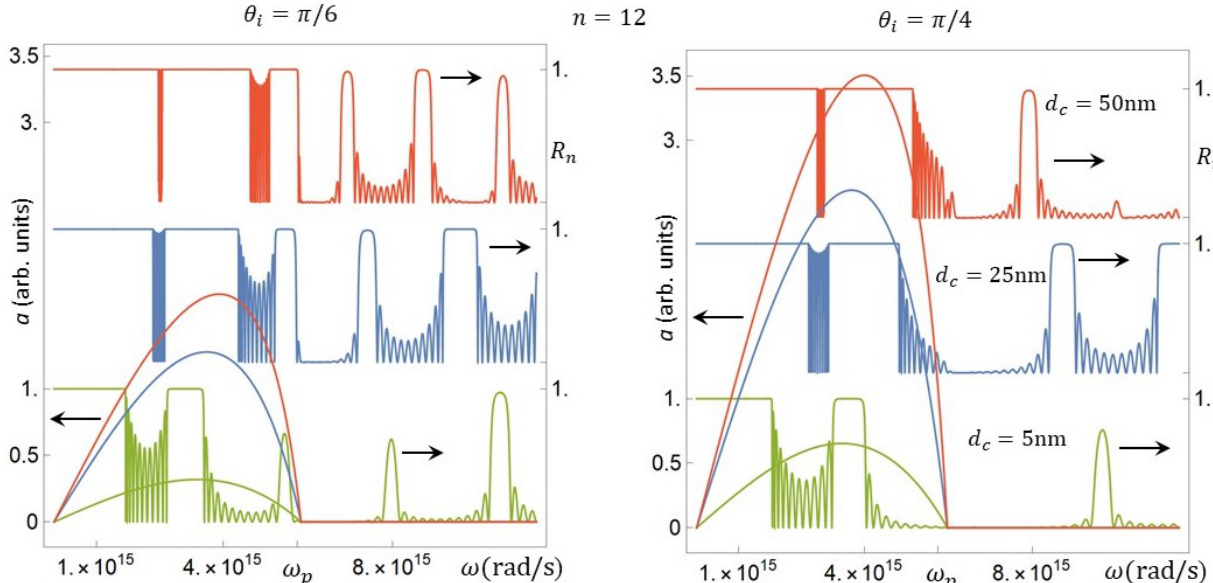
Figure 18. Reflection and absorption factor for a superlattice with n = 12, and two values of the incidence angle. The incidence angle at the left is π /6, and π /4 at the right. The bandwidths and the absorption factor grow with the incidence angle θ i and the conducting layer thicknesses d c